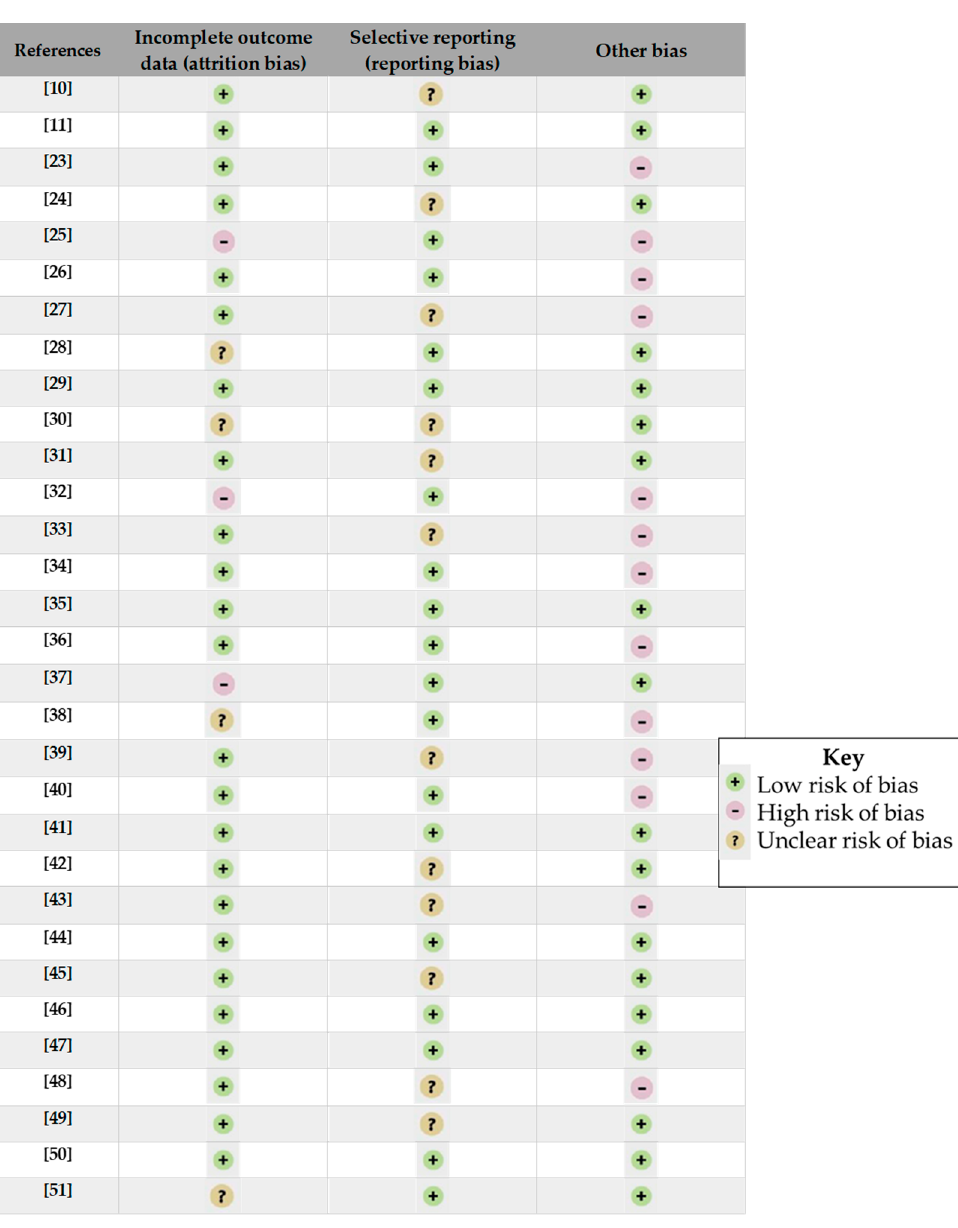
Figure 2. Bias assessment within articles.